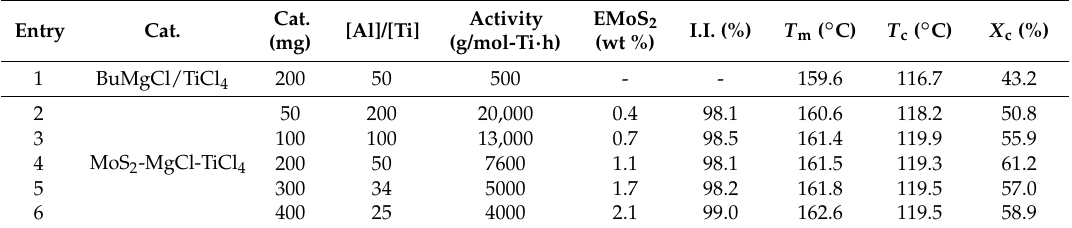
Table 1. Results of propylene polymerization by the MoS 2 -MgCl-supported Ziegler–Natta catalyst. Entry Cat.